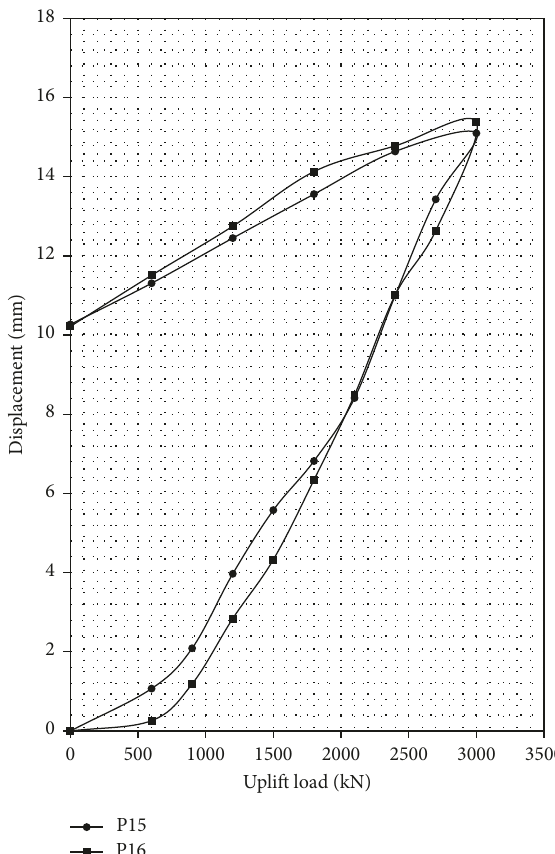
Figure 9: Results of uplift static load tests.